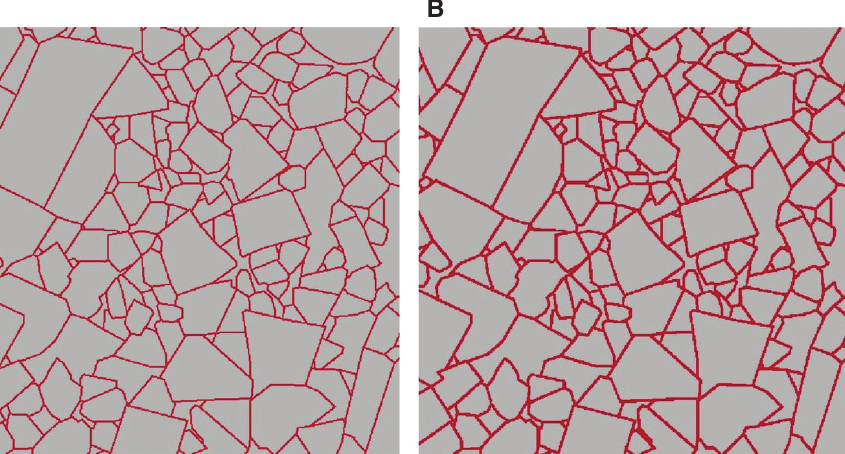
Figure 3: Two-dimensional microgeometries created by introducing continuous boundaries between tungsten carbide particles containing (A) 6% of cobalt and (B) 9% of